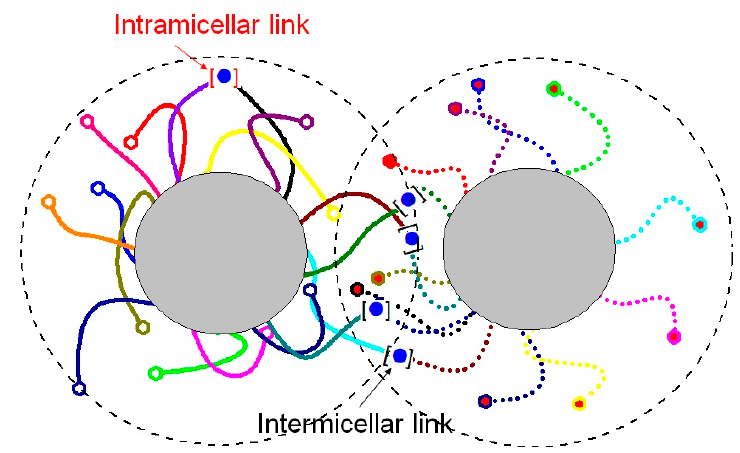
Scheme 1. Cartoon for connection formed by self-assembly of PS- b -PtBA with a terpyridine ligand. The core and coronae are PS and PtBA, respectively. ● Represents the metal